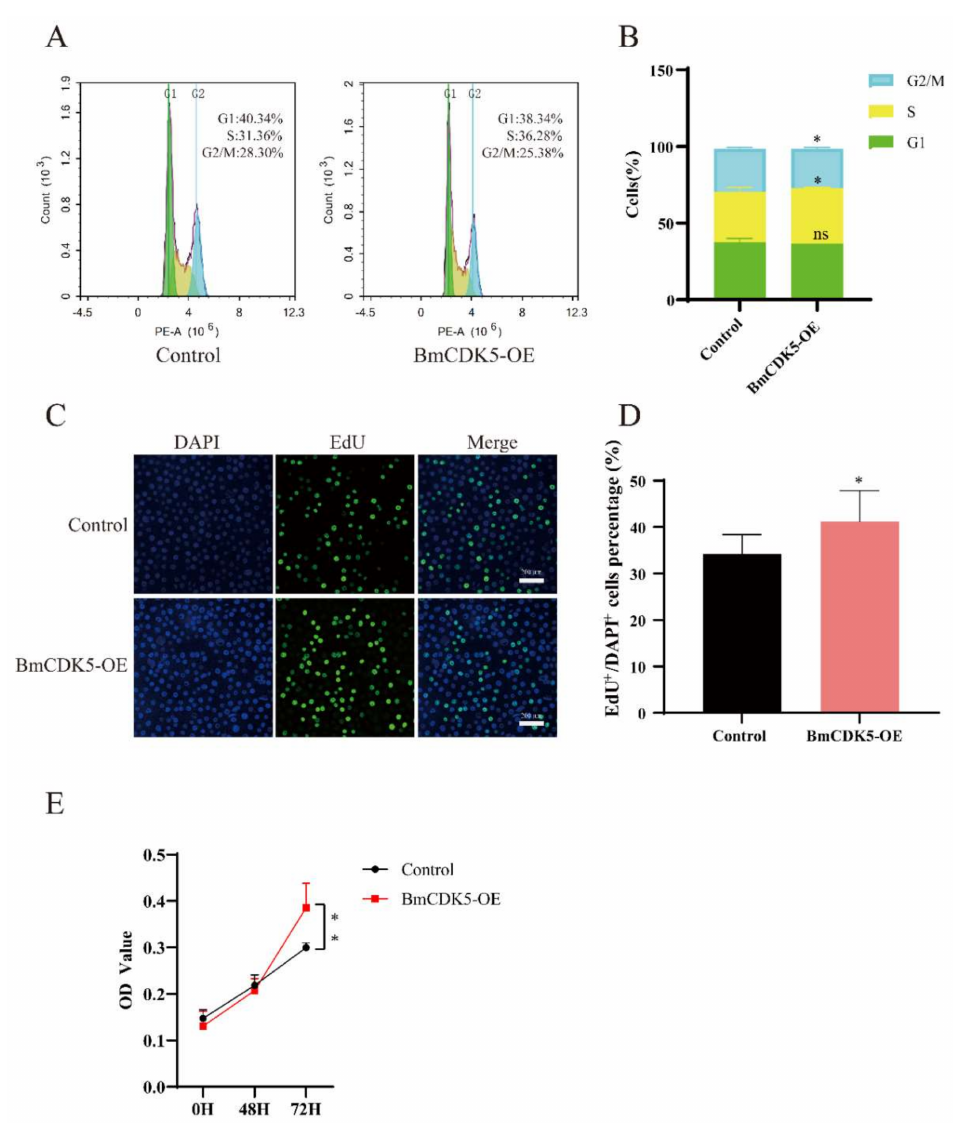
Figure 3. Overexpression of BmCK5 gene in BmNS cells. ( A ) Cell cycle analysis of BmNS cells transfected with control plasmids or pIZ- BmCDK5 plasmids using flow cytometry. ( B ) Statistical analysis of cell percentages at G1, S, and G2/M stages. ( C ) EdU labeling of BmNS cells. Green fluorescence represents EdU positive or EdU + cells. Blue fluorescence represents nuclei stained with DAPI. ( D ) Statistical analysis of EdU positive or EdU + cells. ( E ) The CCK-8 assay was performed to detect cell proliferation ability at 0 h, 48 h, and 72 h (ns p ≥ 0.05, * 0.01 ≤ p < 0.05, ** p <